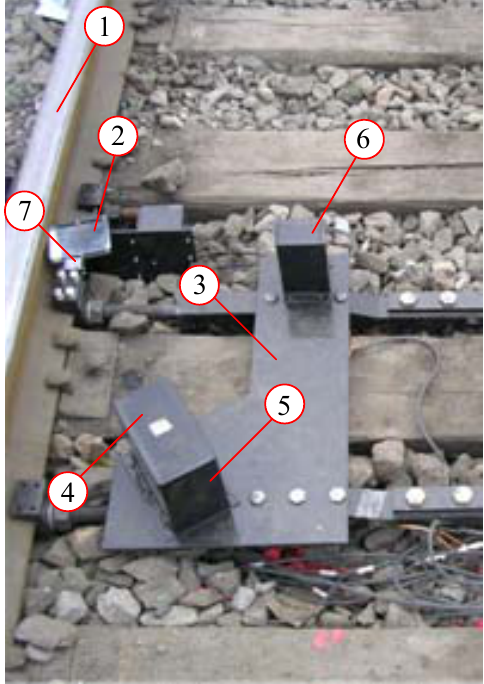
Figure 4. Wheel set image measurement system in the